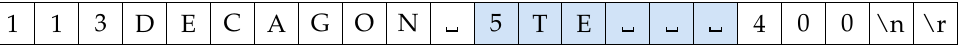
Figure 6. Serial-Digital Interface at 1200 baud (SDI-12) example of a information response